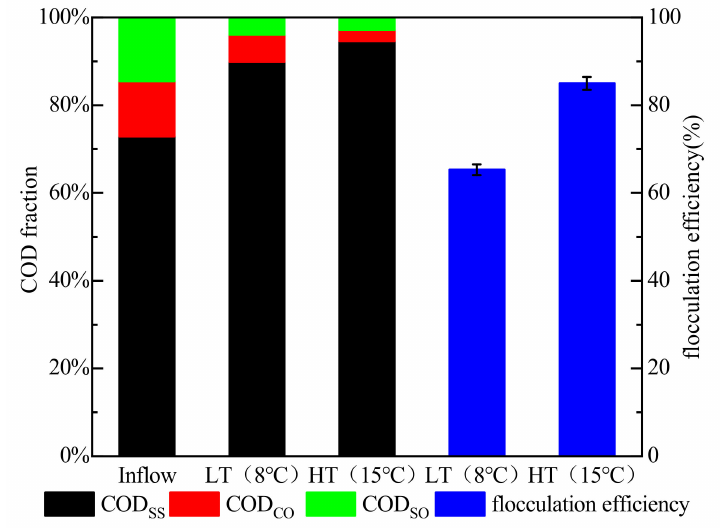
Figure 3. Flocculation e ffi ciency for COD at di ff erent